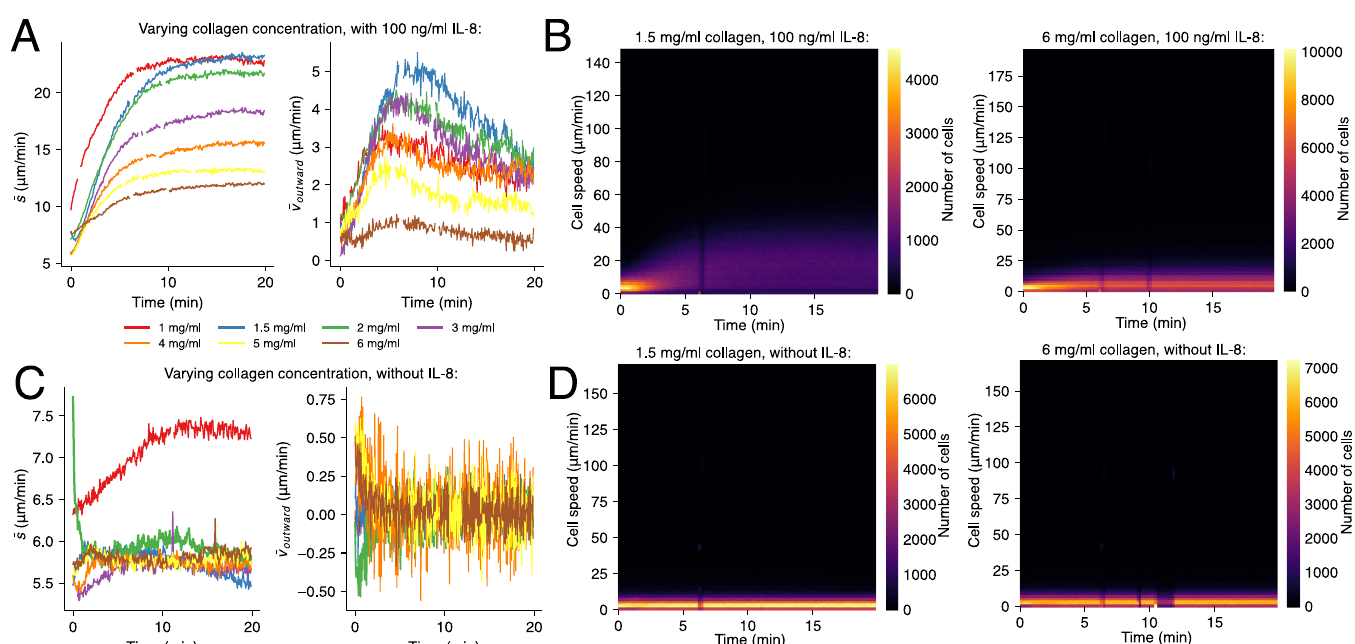
Fig 5. Collagen concentration measurably influences spontaneous migration speed and chemotaxis velocity. (A) Average cell speed and velocity for all collagen concentrations with 100 ng/ml IL-8 added to the surrounding medium. (B) Two-dimensional histograms of measured neutrophil speeds in low (left) versus high concentration collagen, with 100 ng/ml IL-8. A lighter color represents a higher number of cells moving with a specific speed at a specific time. (C) Speed and velocity for all collagen concentrations without chemoattractant. (D) Two-dimensional histograms of measured neutrophil speeds in low (left) versus high concentration collagen, without chemoattractant. Each graph in every figure displays the weighted average of three independent experiments.